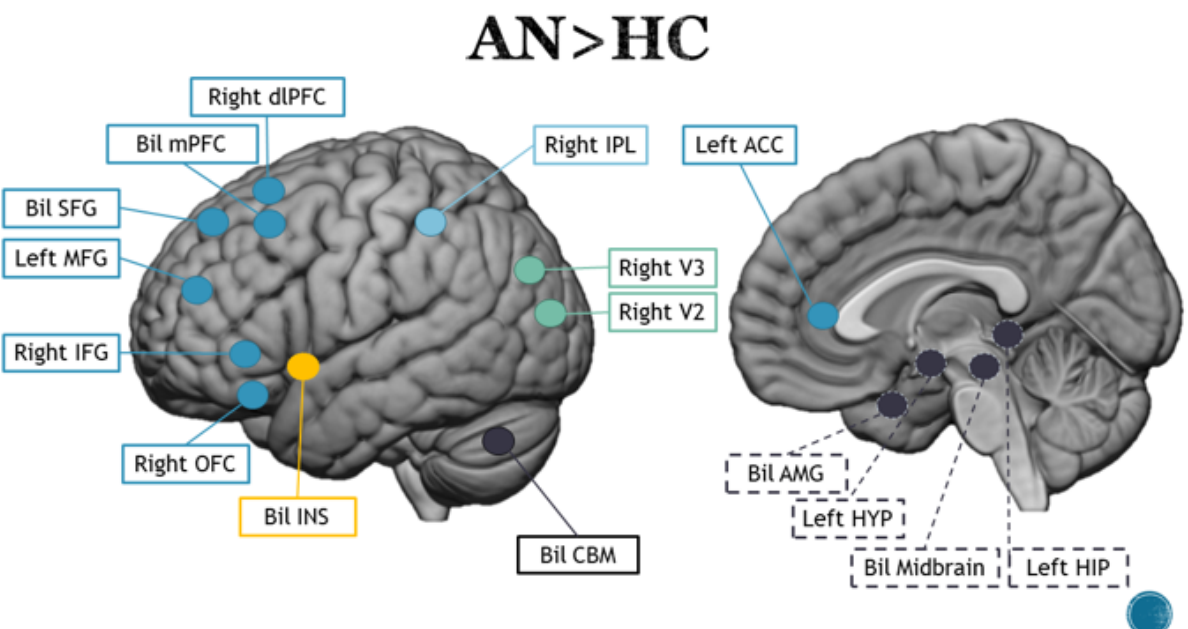
Figure 2. Main brain areas observed in the contrast between anorexic patients and healthy controls. Blue lines represent frontal areas, light blue represent parietal areas, green lines represent occipital areas, yellow lines represent the insula region and black lines represent subcortical regions and the cerebellum. Dotted lines represent mesial regions, whereas solid lines represent lateral and superficial areas.